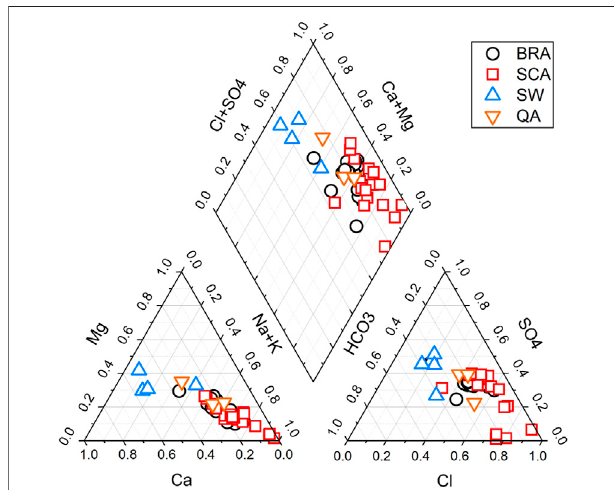
FIGURE 4 | Piper diagram of all water samples.